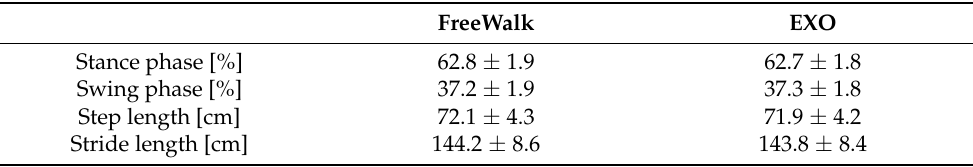
Figure 4. Net metabolic power for each participant during the two conditions of testing. FreeWalk condition (black) and EXO condition (red). Table 1. Spatio-temporal parameters for the two conditions of testing. Data are presented as means ± SD.